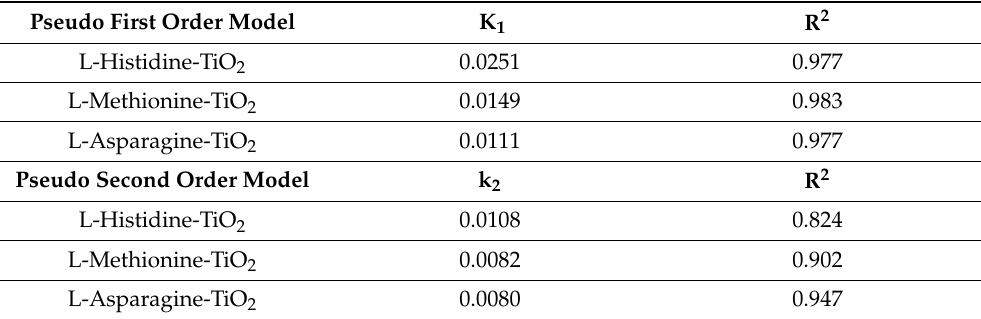
Table 3. Kinetic constant and determination of coefficient of pseudo first and second order models for photocatalytic removal of